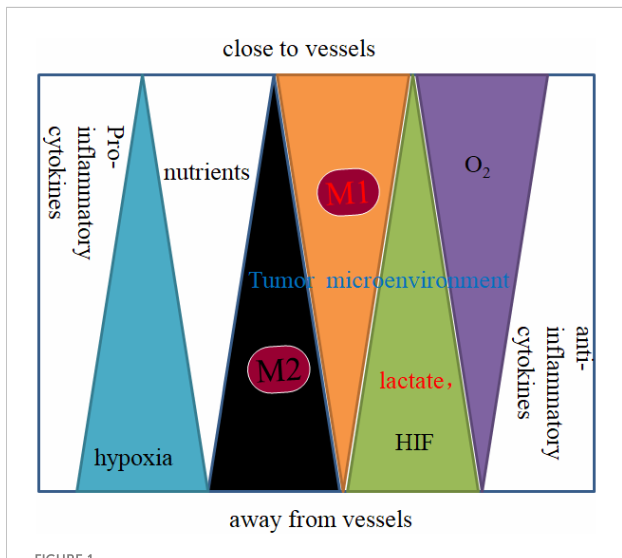
FIGURE 1 Distribution of macrophages in the tumor